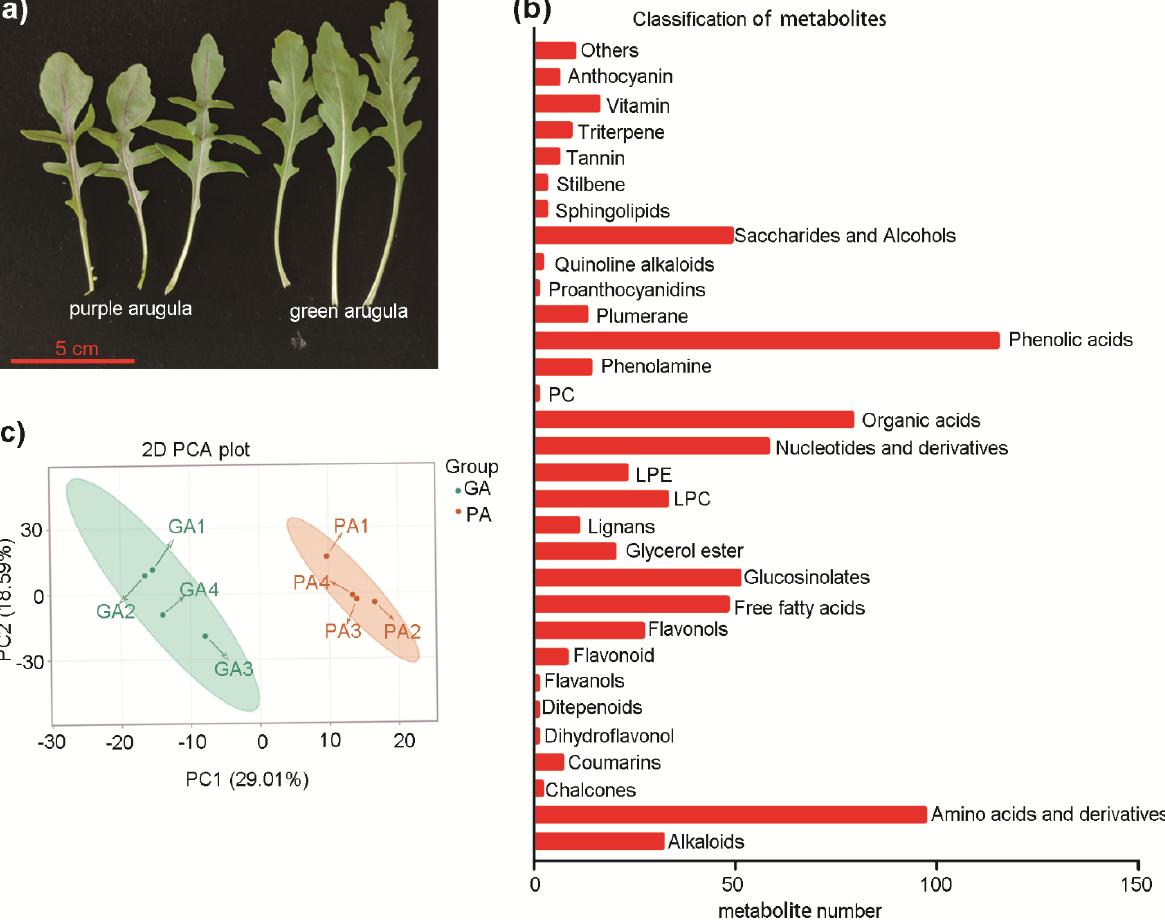
Figure 1. Phenotypes of arugula and overview of metabolome sequencing. ( a ) The phenotypes of two arugula cultivars. Seedlings are 20 − days after germination. Red scale bar = 5 cm. PA represents purple arugula, and GA represents green arugula. ( b ) Classification of detected metabolites. PC: phosphatidylcholine; LPE: Lysophosphatidylethanolamine; LPC: lysophosphatidylcholine. ( c ) Prin- cipal component analysis (PCA) of the variance-stabilized estimated raw counts of differentially expressed metabolites (DEMs).